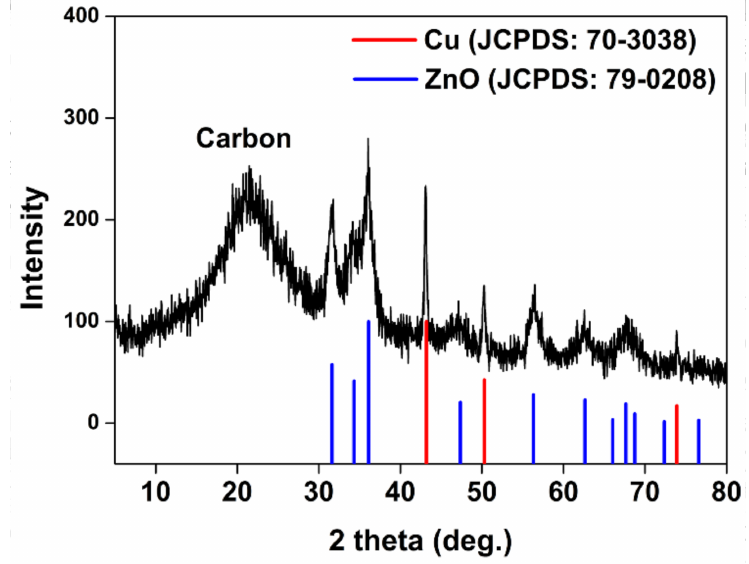
Figure 4. Powder XRD pattern of the Cu–ZnO@C compound prepared by heat-treated Complex at 600 ◦ C under N 2